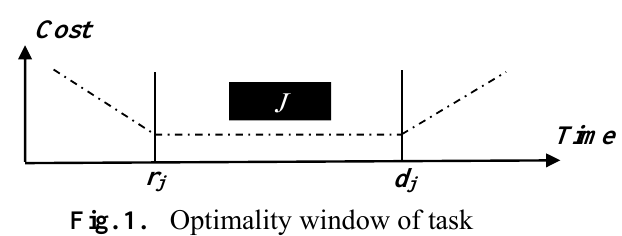
Fig. 1. Optimality window of